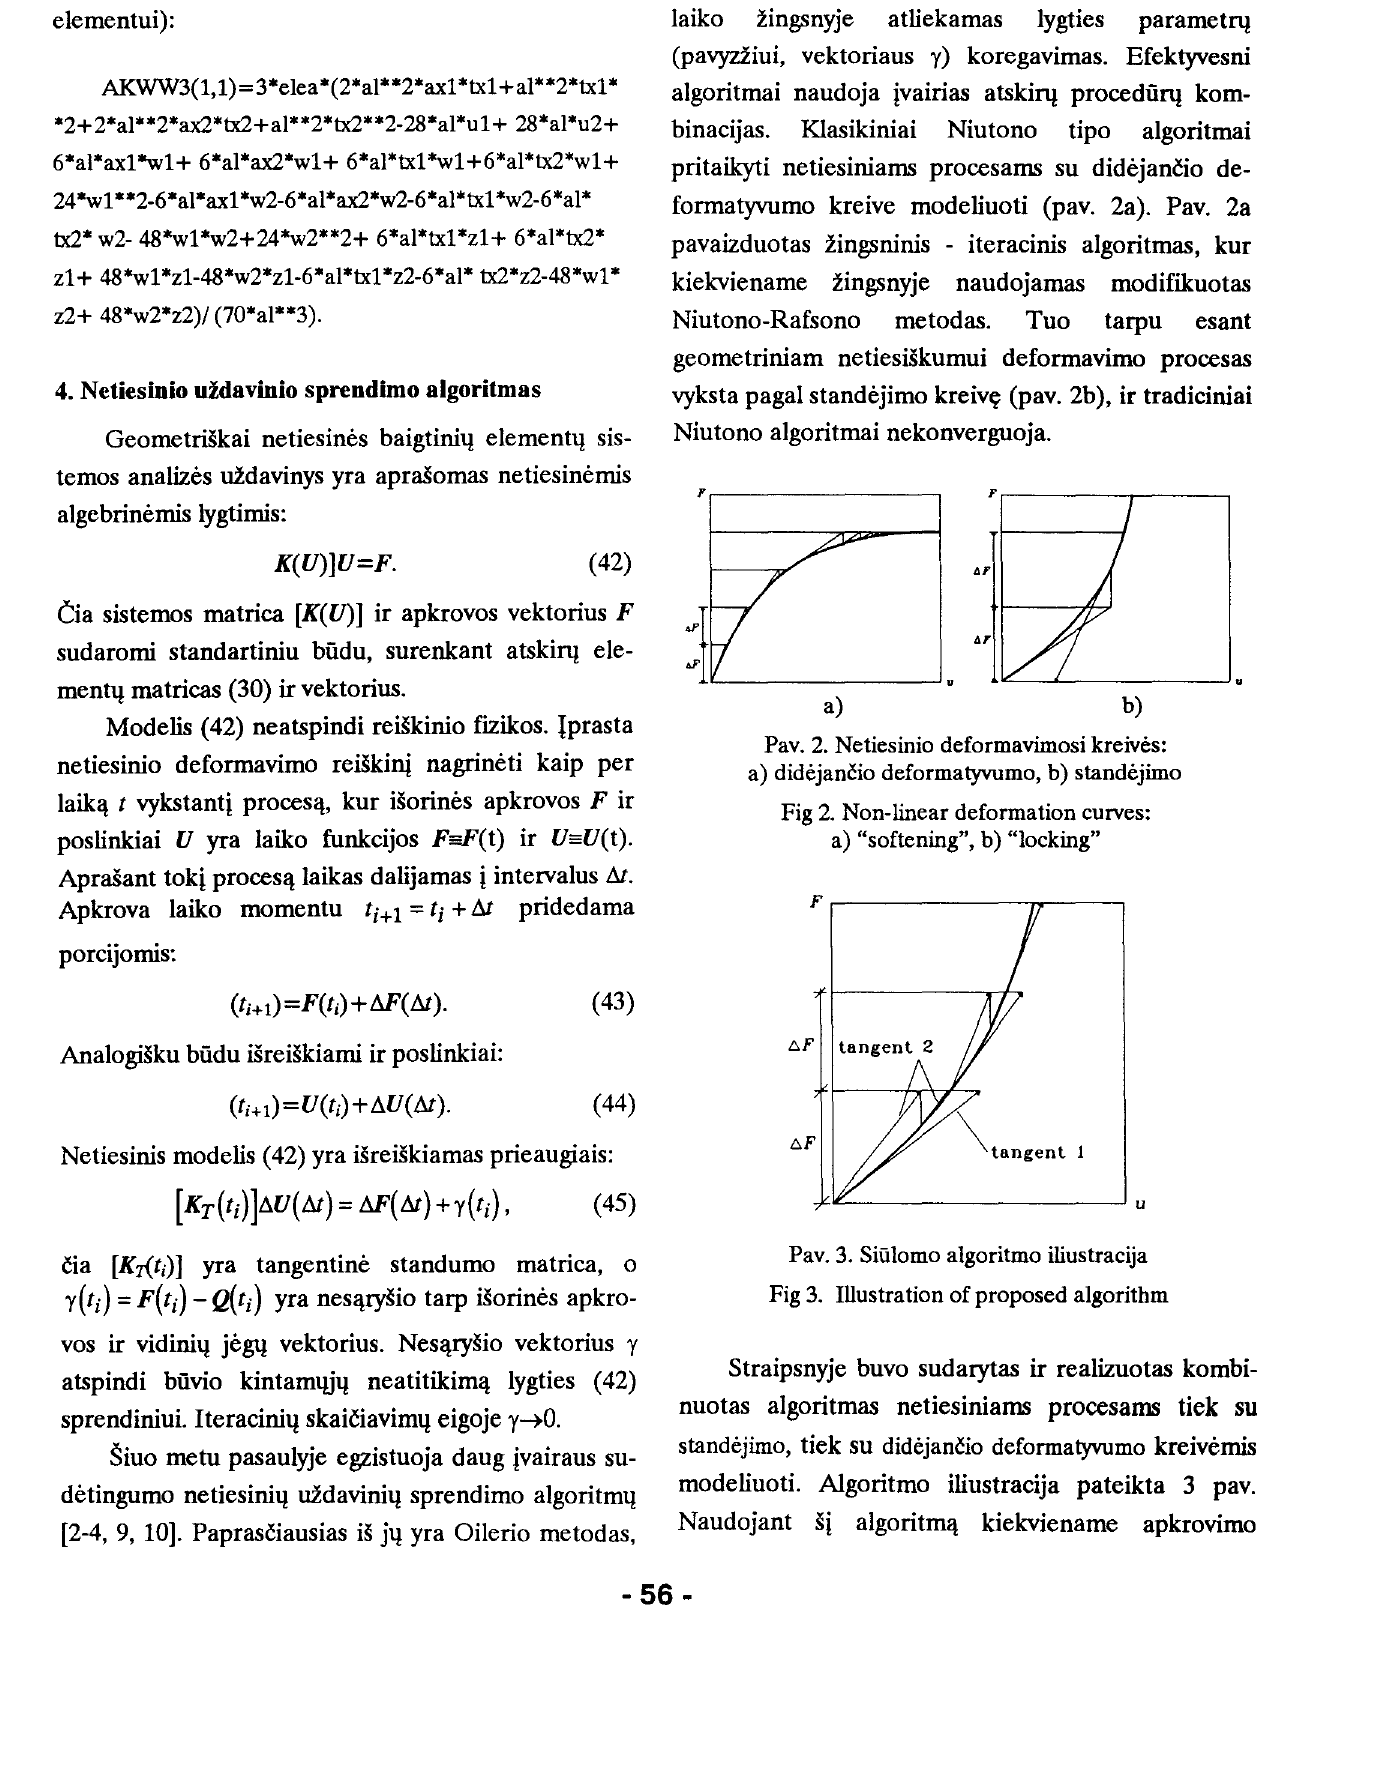
Fig 2. Non-linear deformation curves: